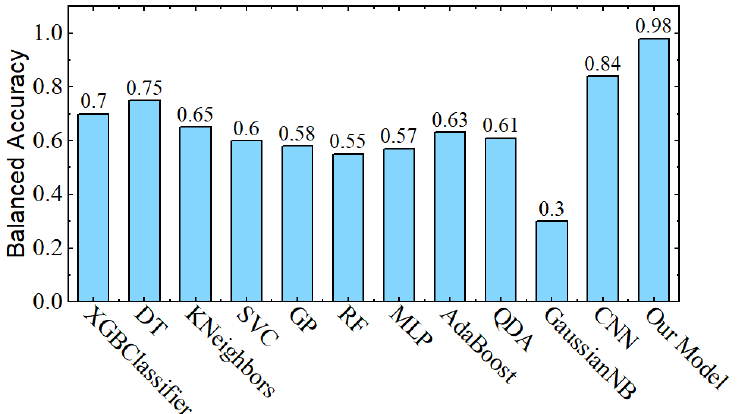
Figure 14. Final accuracy results of the proposed model in comparison with other paradigms.